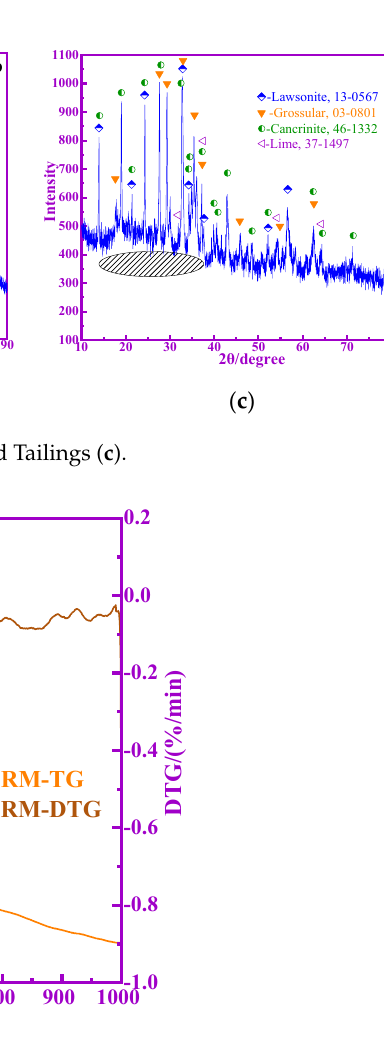
at 650 ◦ C, the free -OH in the BRM is converted to an associated -OH, which indicates a telescopic vibration of C-O, and about 1450 cm − 1 corresponds to the antisymmetric tele- scopic vibration of C-O. The absorption peak in the range of 800–1200 cm − 1 is asymmetric The peak at 1090 cm − 1 is caused by the tensile vibration of O-Si-(Si). The peak at 996 cm − 1